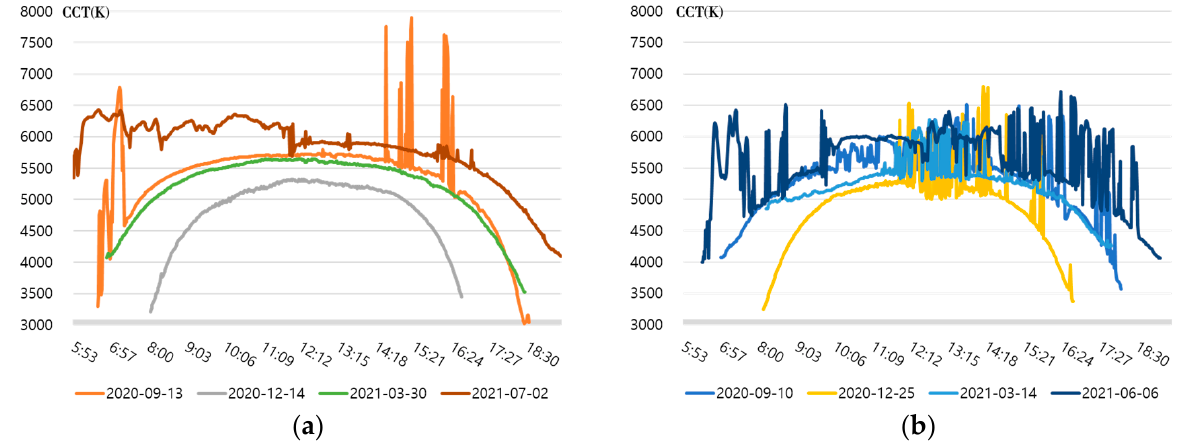
Figure 2. Color temperature distribution by hour according to irregular color temperature inclusion. ( a ) Irregular color temperature inclusion of less than 15%, ( b ) Irregular color temperature inclusion exceeding 15%.